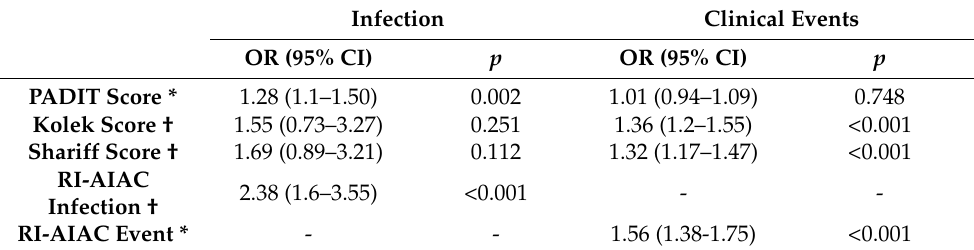
Table 6. Logistic regression of clinical